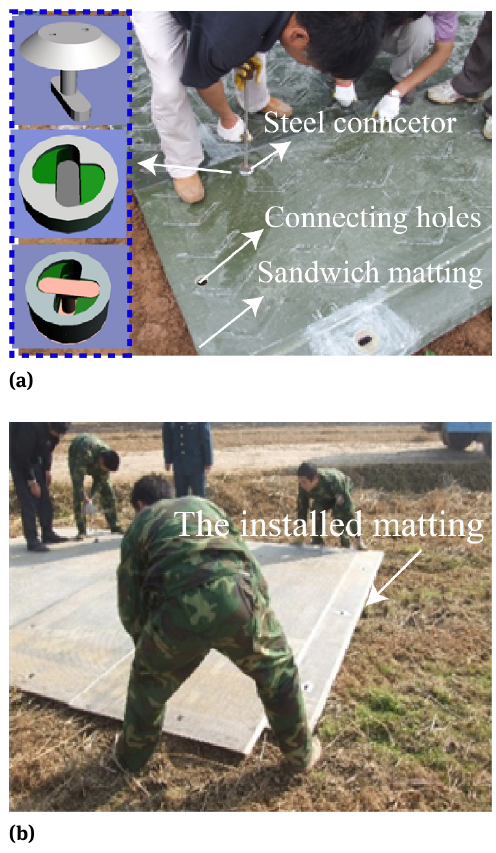
Figure 3: The installation of sandwich matting. (a) install sandwich matting, (b) the platform for vehicle driving.